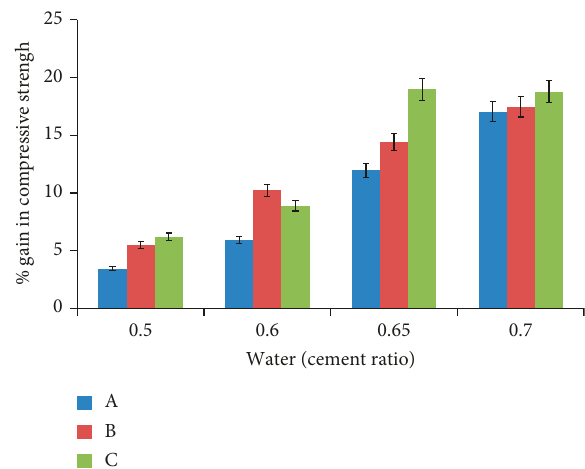
Figure 6: Percent loss in compressive strength after exposure of mortars to WLI.